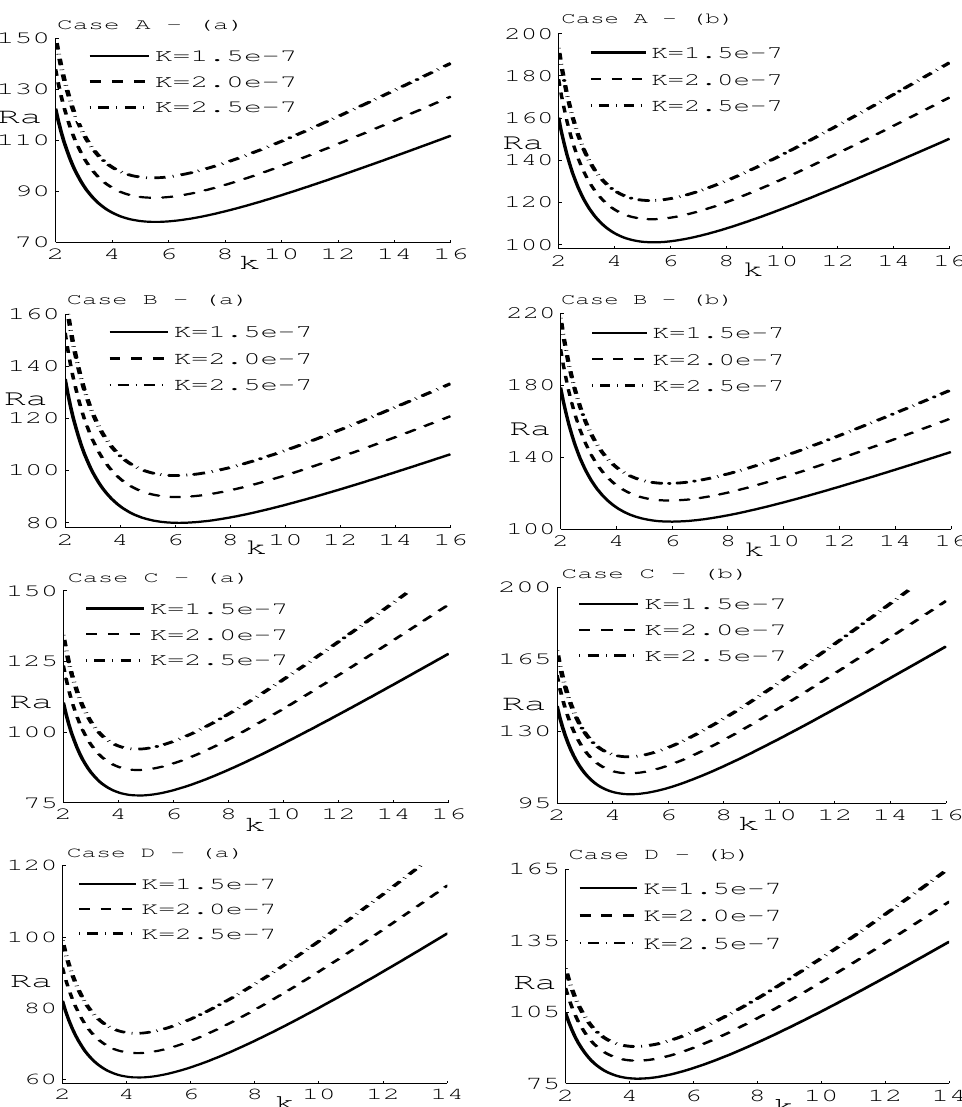
Figure 4. Neutral curves for different values of the permeability parameter K for ( a ) water-based ferrofluid and ( b ) ester-based ferrofluid for Case A to Case D. The fixed parameter values are α L = 2, (cid:101) = 0.35, and d = 0.001